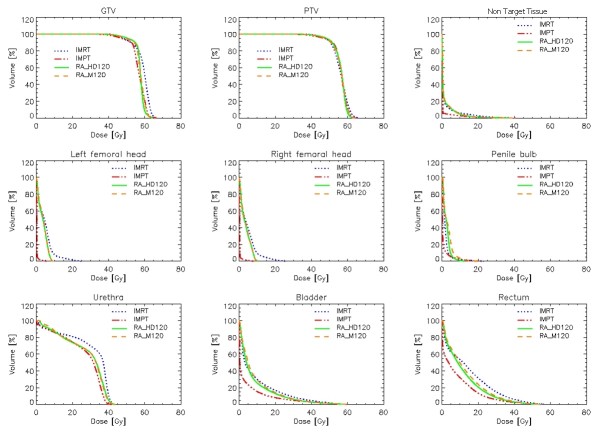
Mean DVHs for CTV, PTV and OARs.